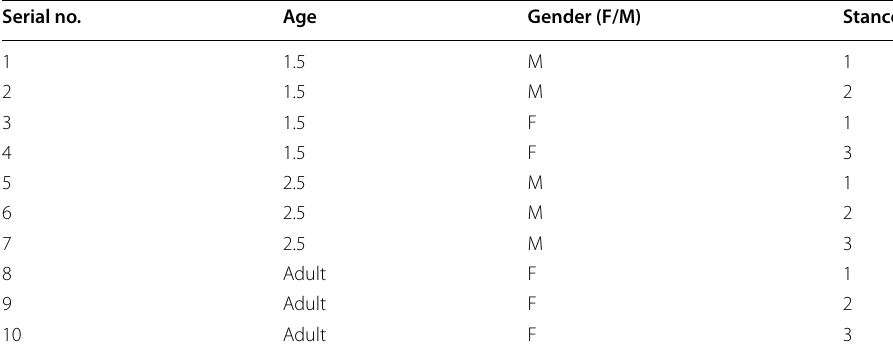
Table 6 Data of randomly selected ten yaks Serial